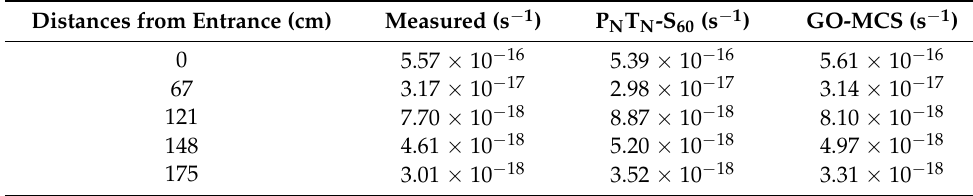
Table 2. Calculated and measured values of 115 In(n, n’) 115m In reactive rate. Distances from Entrance